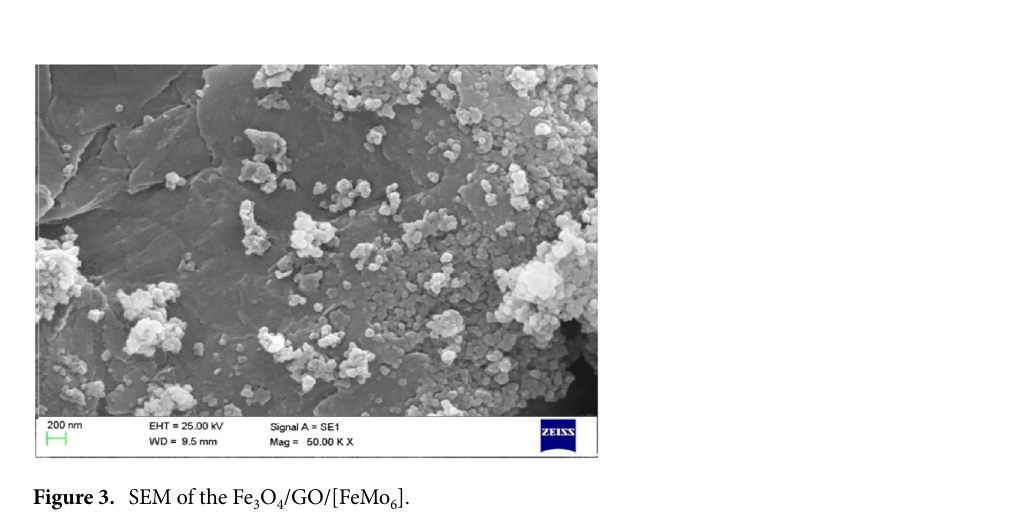
Fig. 5. The thermal gravimetric analysis plot of the catalyst demonstrates a three-step mass loss around 25–650 °C. The first 4.62% weight loss at 100 °C can be accounted for solvent associated with the compound 60 . The weight